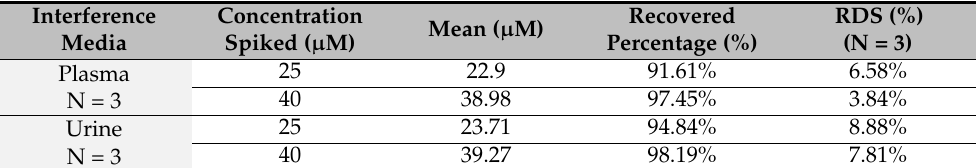
Table 3. Values obtained for the recovery analysis of spiked urine and plasma samples when known concentrations of chlorferron were analysed by DPV using a CFN-MIP sensor. Interference